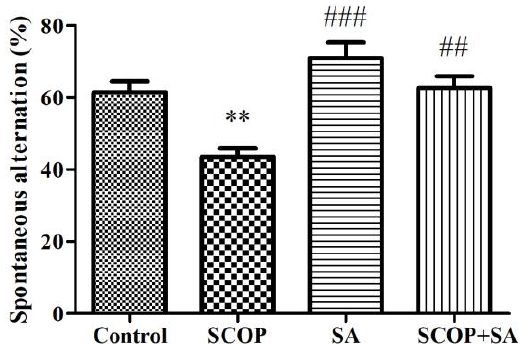
Figure 4. The effect of SA on short-term spatial memory in SCOP-treated. fEPSP total activity (%) change induced by TBS while treatment with 10 µ M SA and 300 µ M SCOP in the organotypic cultured hippocampus. n = 4. ** p < 0.01 vs. the control group. ### p < 0.001, ## p < 0.01 vs. the SCOP group. Data were analyzed by one-way ANOVA with LSD test.